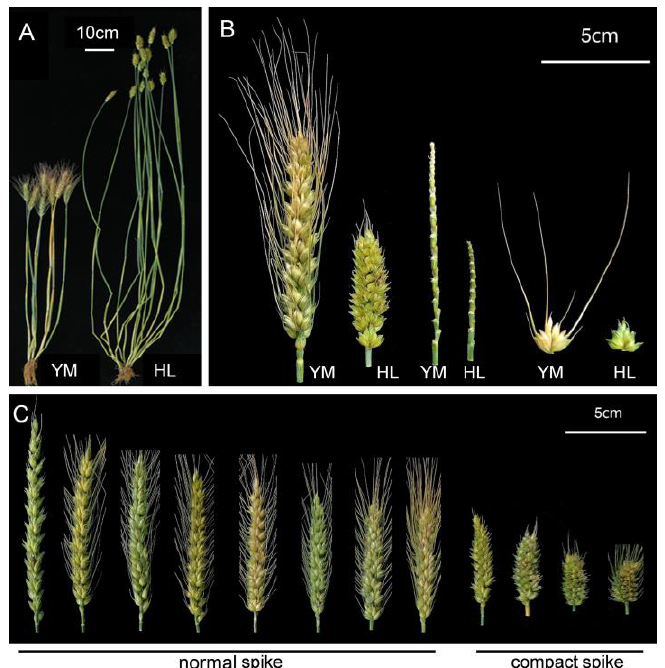
Figure 1. Phenotypes of the parents Yangmai 158 (YM) and Triticum compactum Hiller (HL) and their derived representative RILs. ( A ) Plant height of parents; ( B ) Spikes, rachis and spikelets of parents; ( C ) Representative RILs with normal and compact spike.